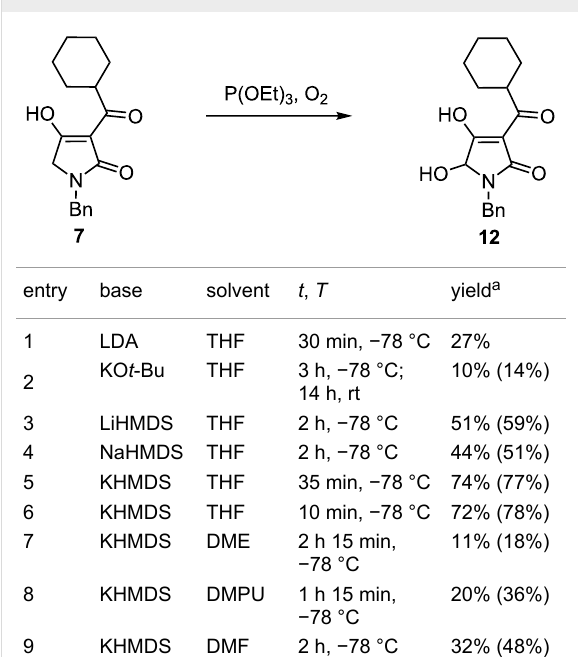
Table 2: Condition optimization for hydroxylation of tetramic acid 7 .